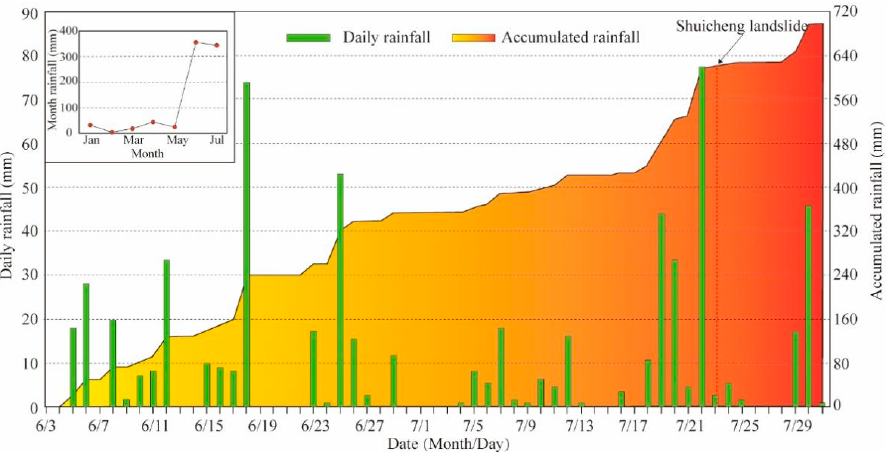
Figure 9. Rainfall statistics of Jichang Town before and after the occurrence of the Shuicheng landslide [11].